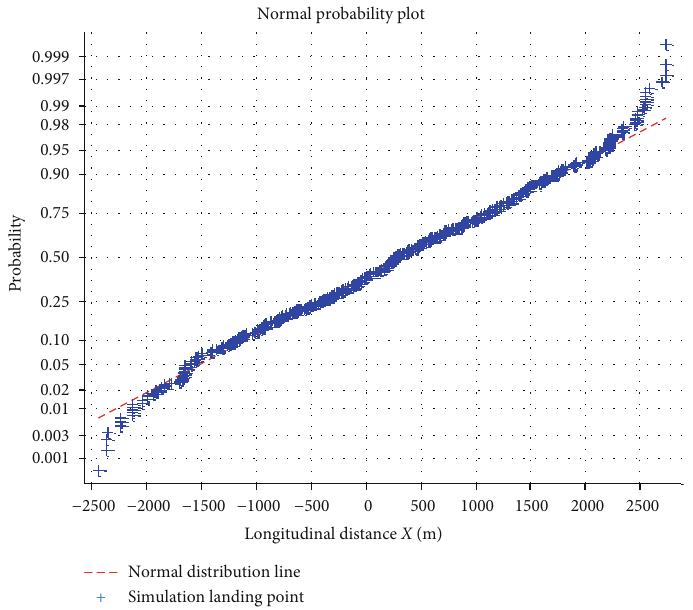
Figure 10: Fall point longitudinal coordinate normality test.